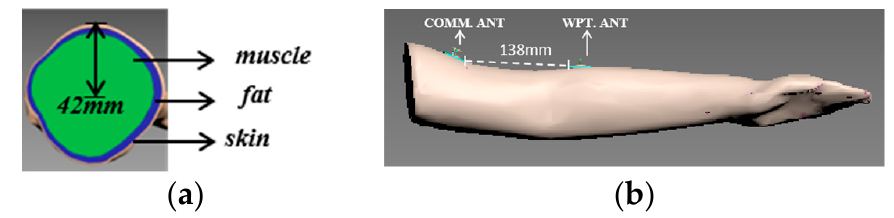
Figure 4. Real female arm model: ( a ) three-layered structure and ( b ) arm and antennas.